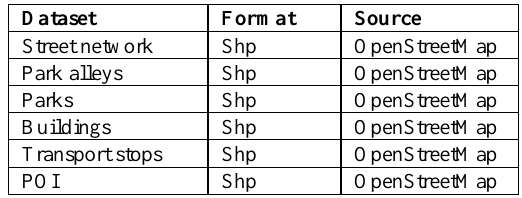
Table 1 . Used datasets.